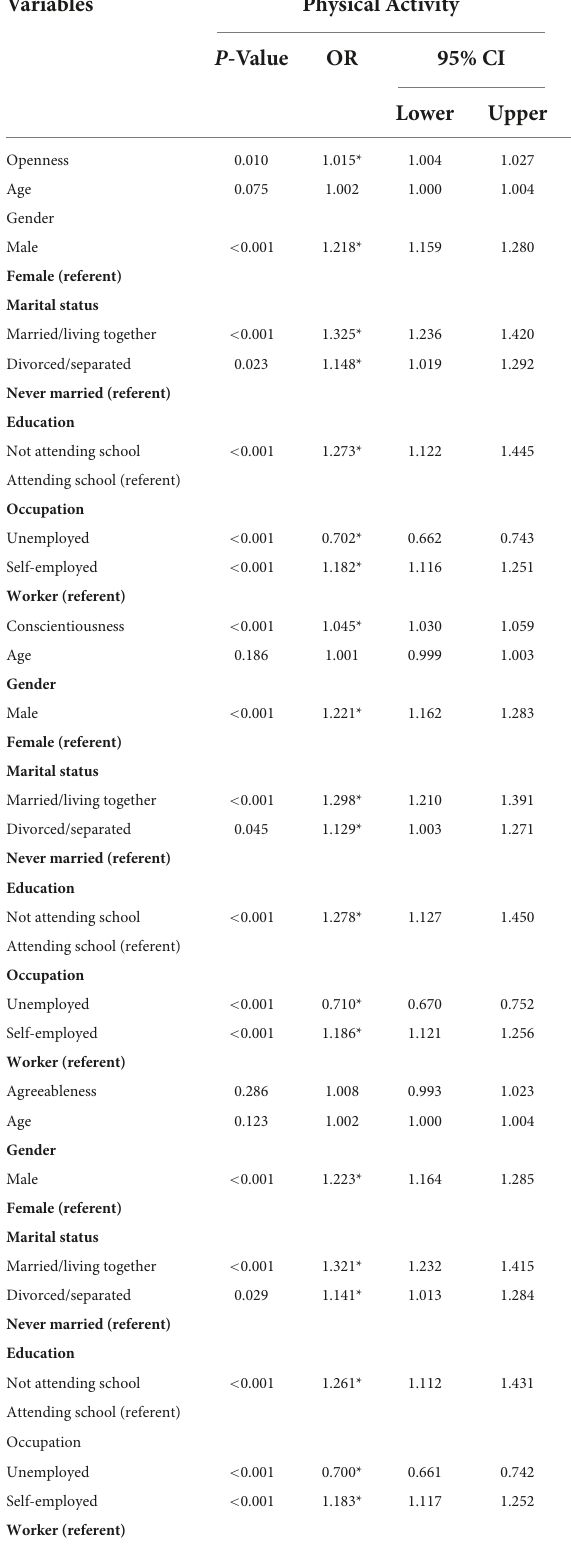
TABLE 3 Multivariate analysis between Big Five Personality Traits with physical activity and control variables.